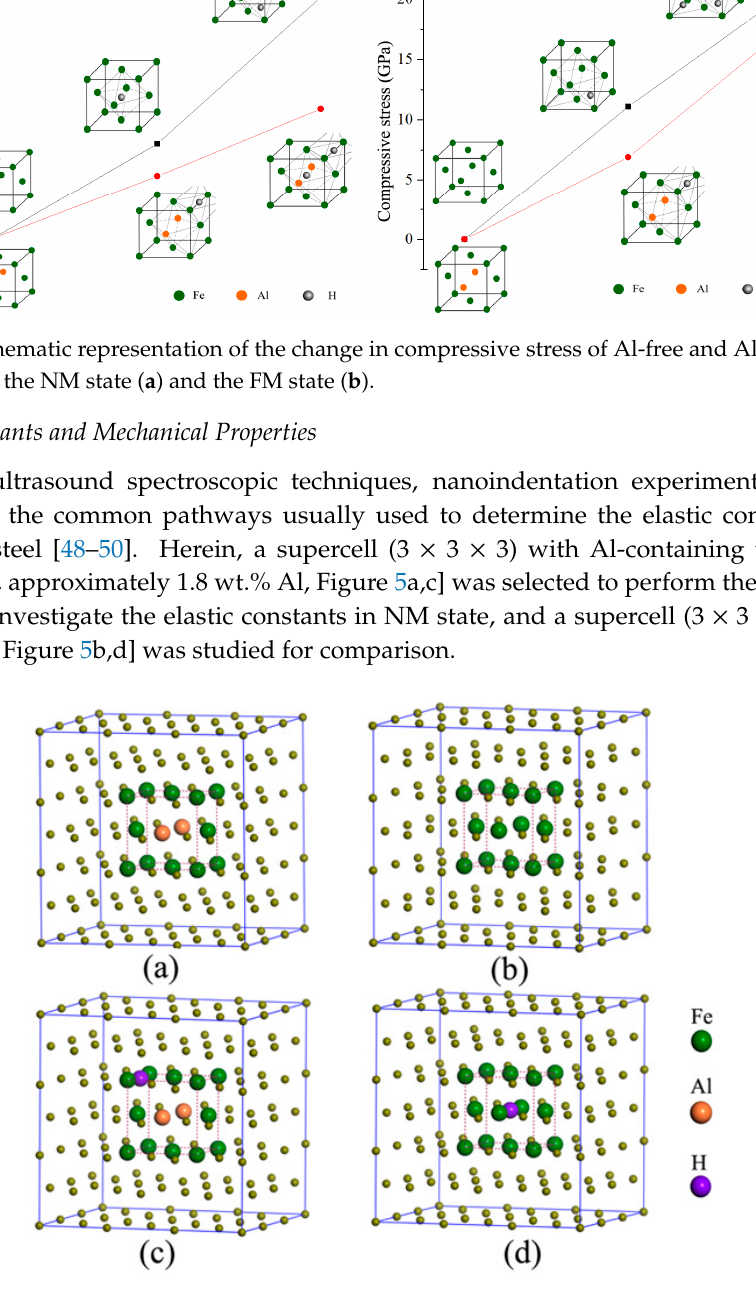
Figure 5. The atomic structure of Fe 106 Al 2 ( a ), Fe 108 ( b ), Fe 106 Al 2 H ( c ), and Fe 108 H ( d ).